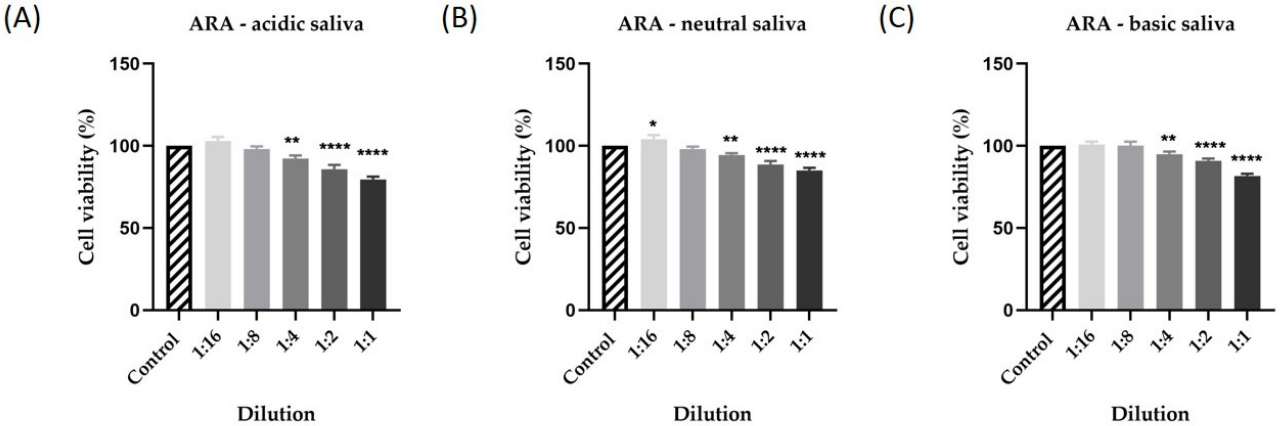
Figure 5. In vitro evaluation of the effect exerted by DM suspended in ( A ) acidic saliva (pH = 3), ( B ) neutral saliva (pH = 7), and ( C ) basic saliva (pH = 10) on the viability of HaCaT cells following a 72 h treatment by performing the MTT assay. Five different dilutions were tested (1:16, 1:8, 1:4, 1:2, 1:1). Data are presented as viability percentages (%) normalized to control and expressed as mean values ± SD of three independent experiments performed in triplicate. The statistical differences between the control and the treated group were verified by applying the one-way ANOVA analysis followed by Dunett’s multiple comparisons post-test (* p < 0.1, ** p < 0.01, and **** p < 0.0001).